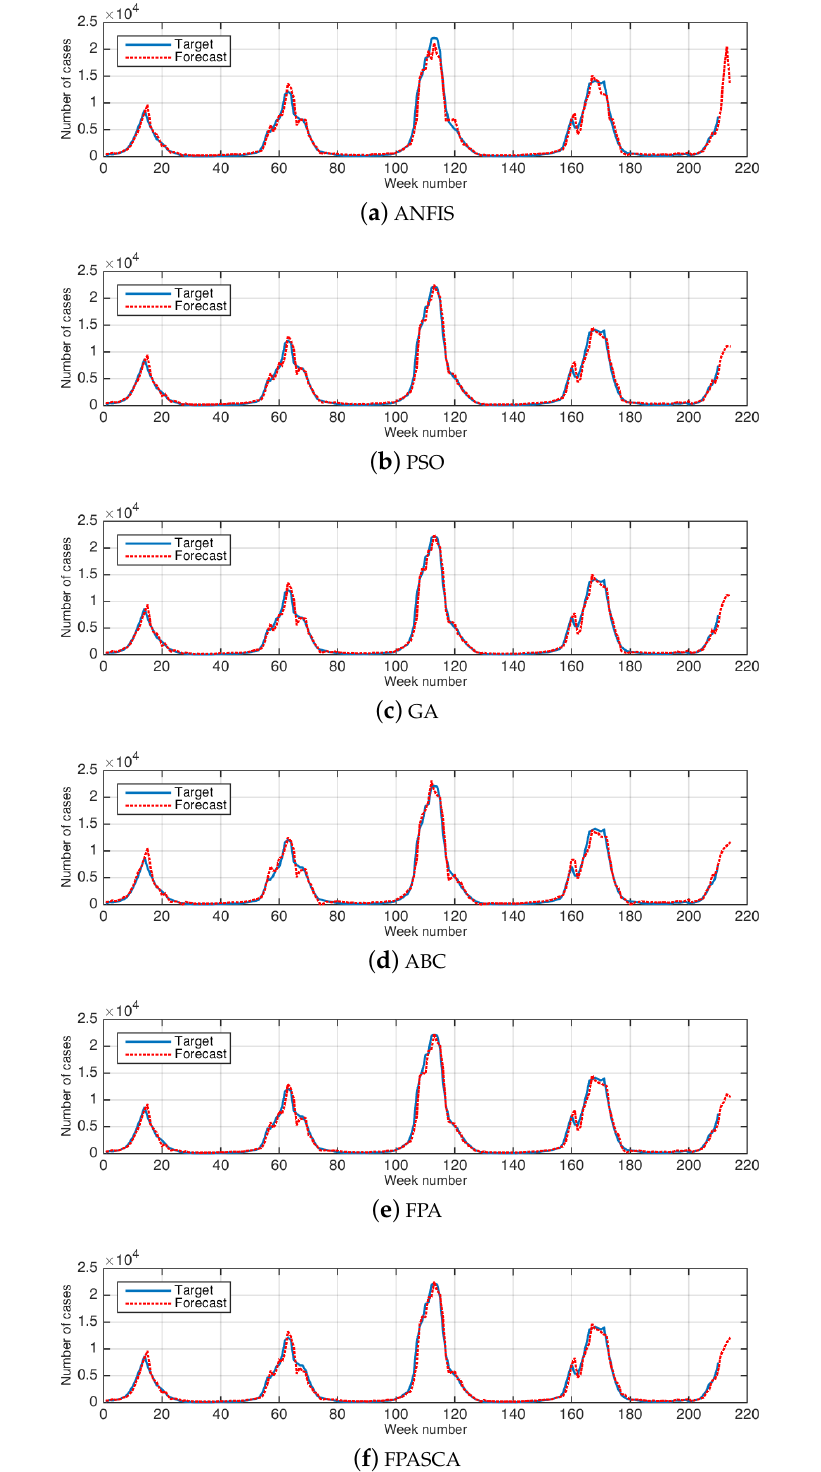
Figure 3. The results of real and forecasted data for influenza cases in the USA. ( a ) ANFIS, ( b ) PSO, ( c ) GA, ( d ) ABC, ( e ) FPA, ( f )